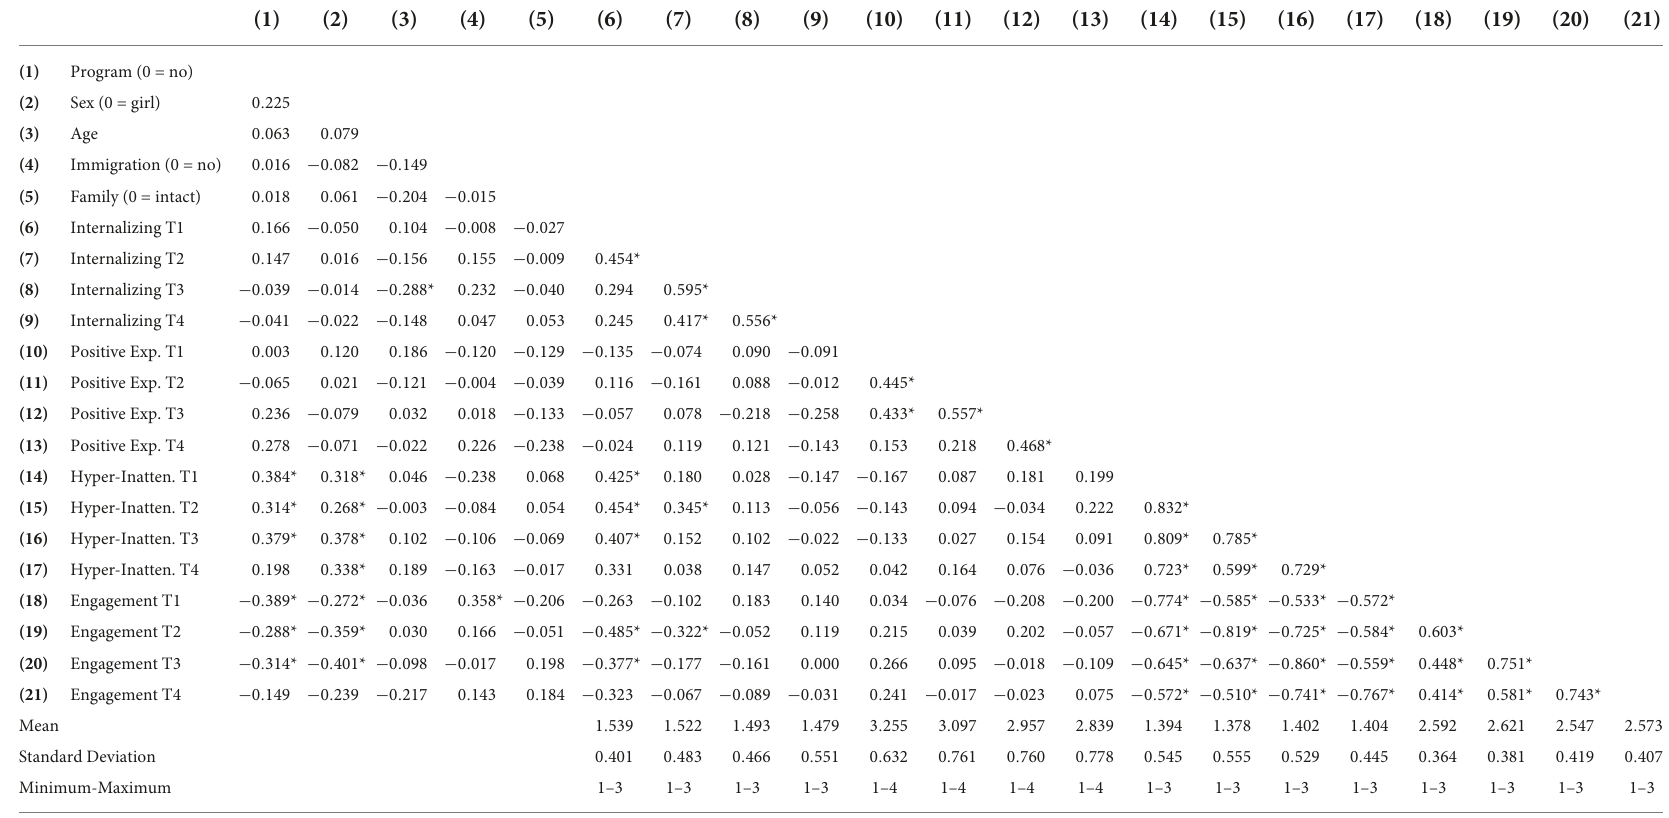
TABLE 1 Correlations between study